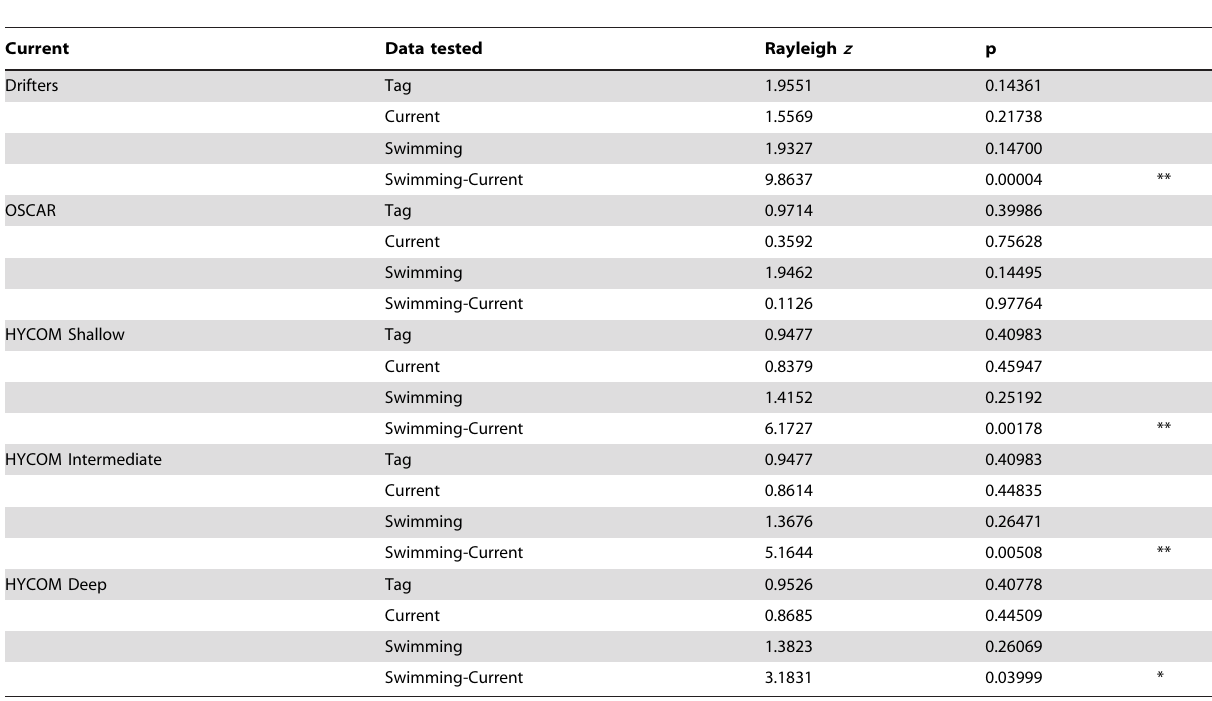
Table 3. Summary of Rayleigh’s z statistical tests of directional uniformity applied to the daily directional data from tag movement, current direction, swimming direction, and the difference between the directions of swimming and prevailing